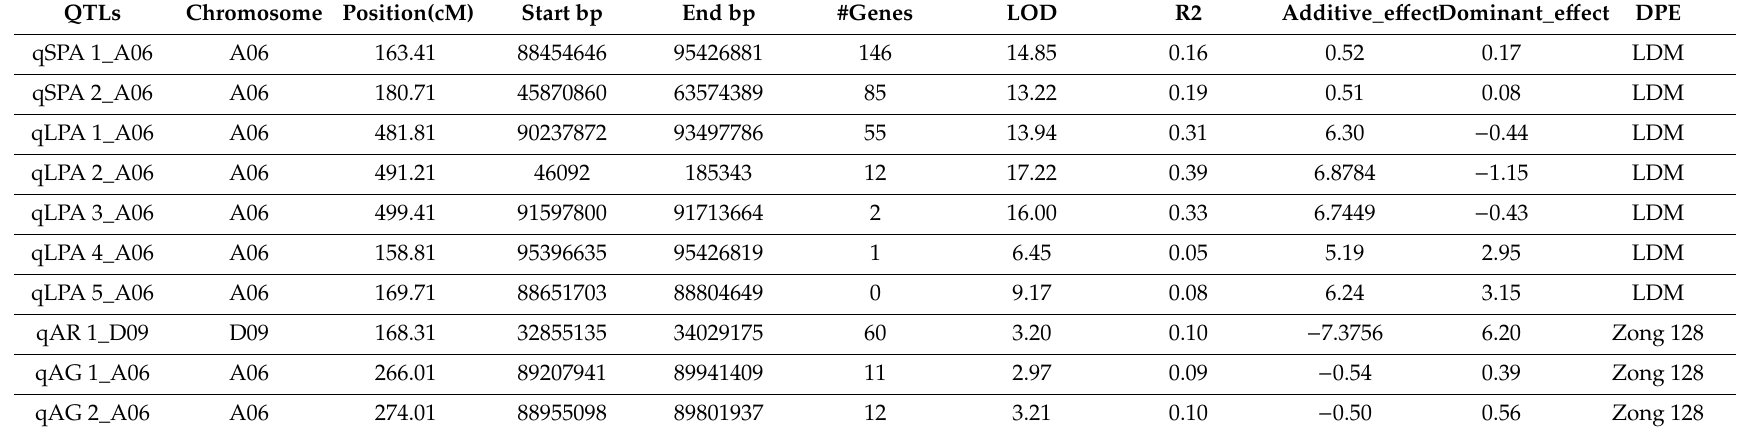
Table 3. List of QTLs (quantitative trait loci) related to leaf and stem pubescence, aphid rate and aphid